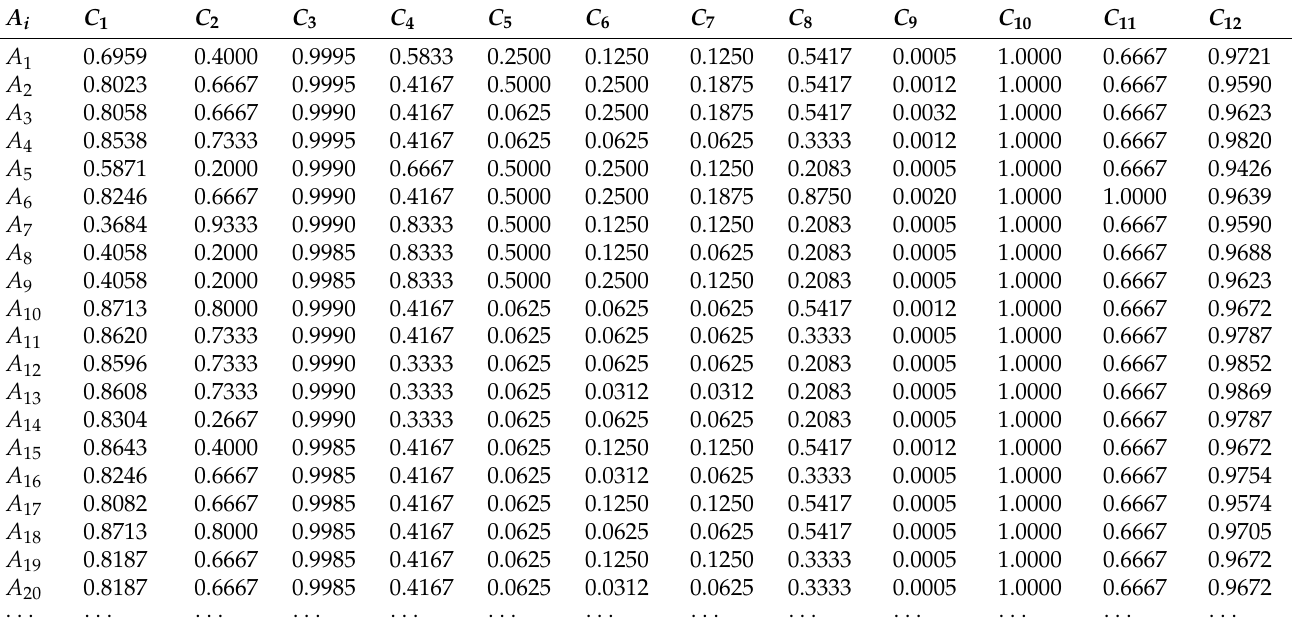
Table 14. Normalized decision matrix for the whole set of alternatives.